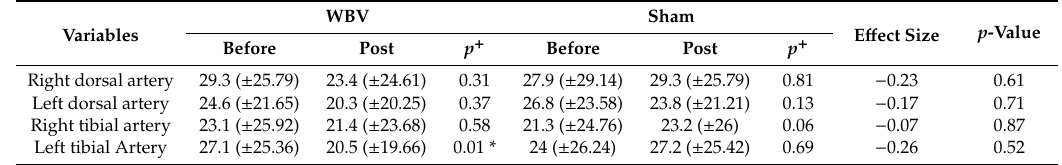
Table 3. Analysis of mean blood flow velocity in m / s (and standard deviation) before and after intervention (intra and intergroup) and e ff ect